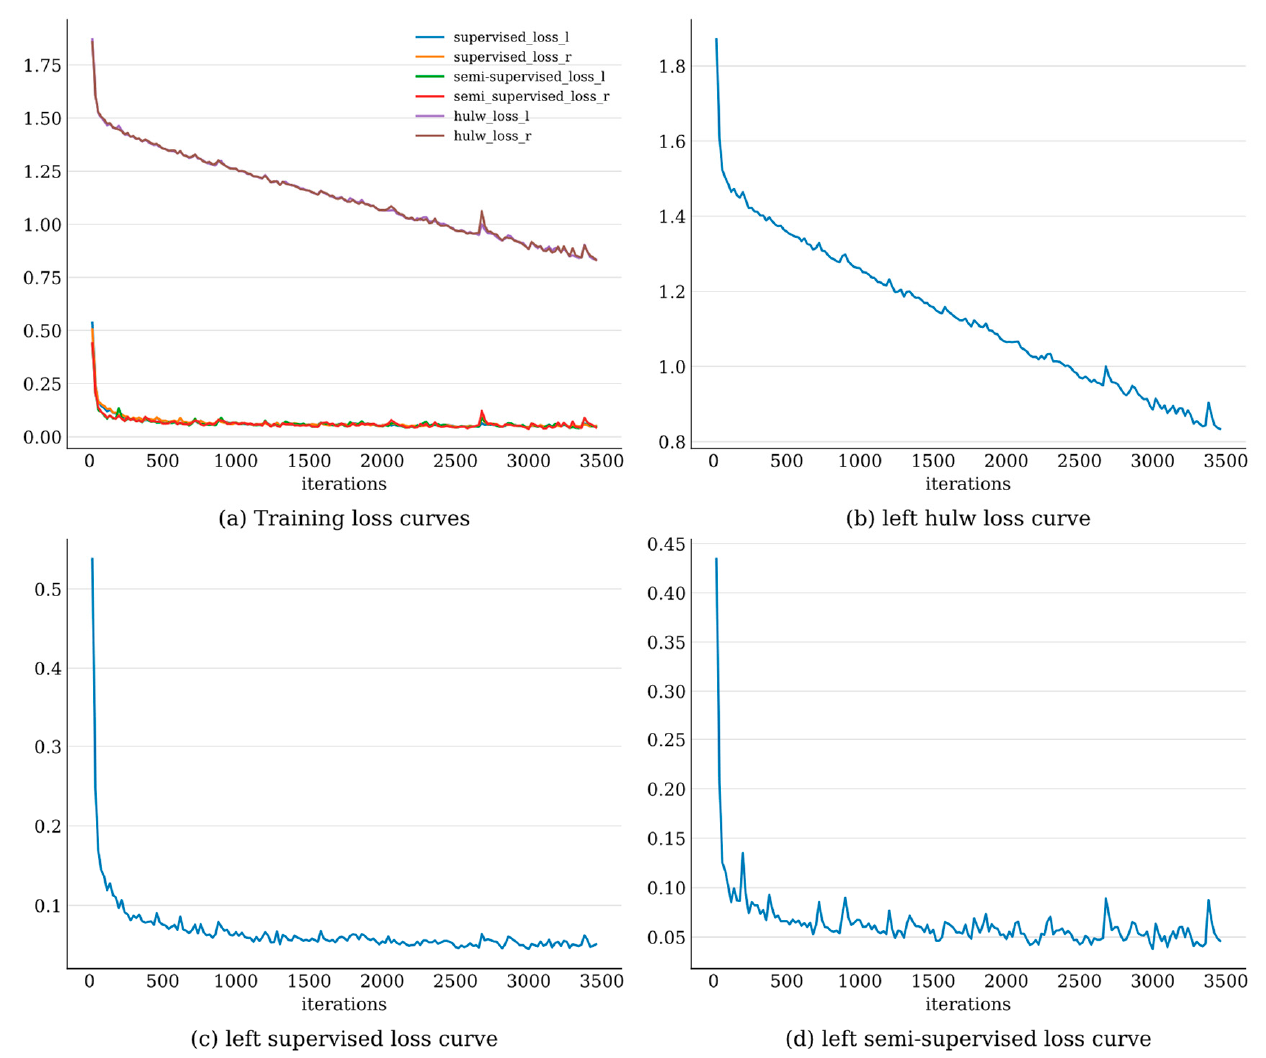
Figure 8. Training loss curves of MTCSNet on SPARCS dataset. ( a ): six loss curves (left supervised loss, right supervised loss, left semi-supervised loss, right semi-supervised loss, left hulw loss, right hulw loss). ( b ): left hulw loss curve. ( c ): left supervised loss curve. ( d ): left semi-supervised loss curve.